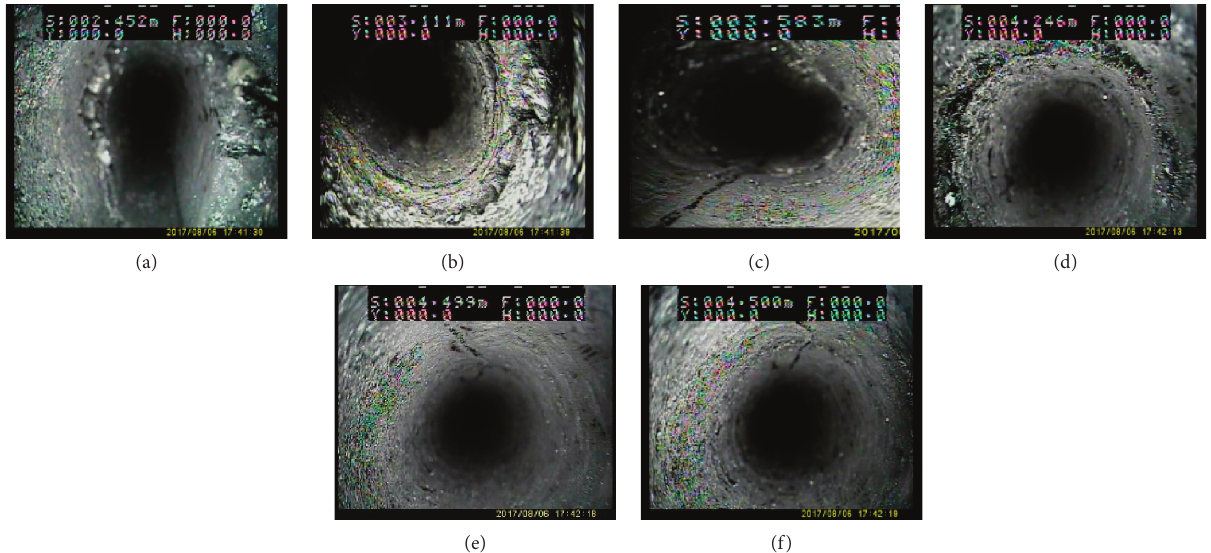
Figure 10: The distribution of the surrounding rock in the roof anchorage area. (a) 0.2m. (b) 0.8m. (c) 1.1m. (d) 1.5m. (e) 1.8m. (f) 2.0m.